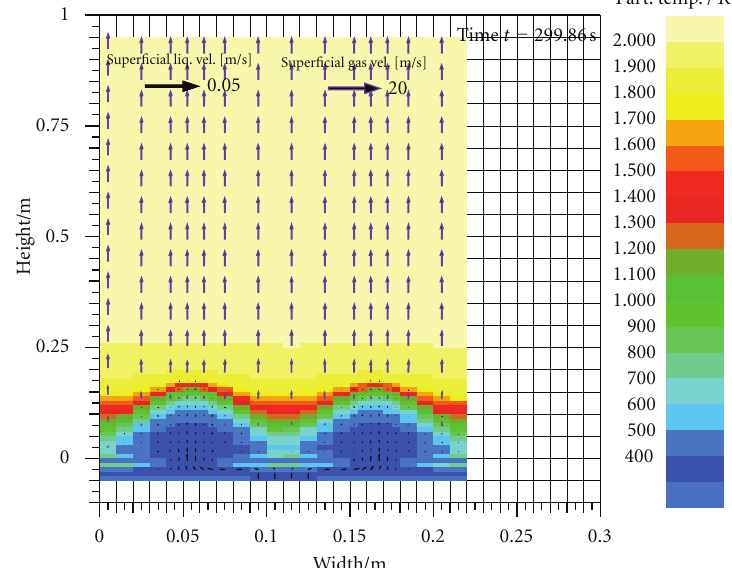
Figure 4: MEWA calculation of the velocities and temperatures in the VULCANO COMET experiment.